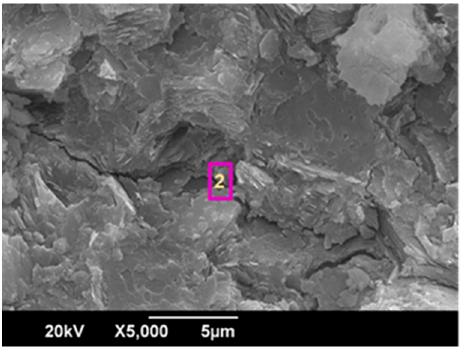
Figure 11. SEM micrographs with EDS for sample to which 10 wt % TiO 2 was added (28 days). Table 3. Composition of elements measured via EDS as shown in Figure 10.